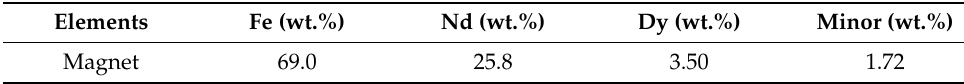
Table 1. Chemical composition of the magnet by XRF.